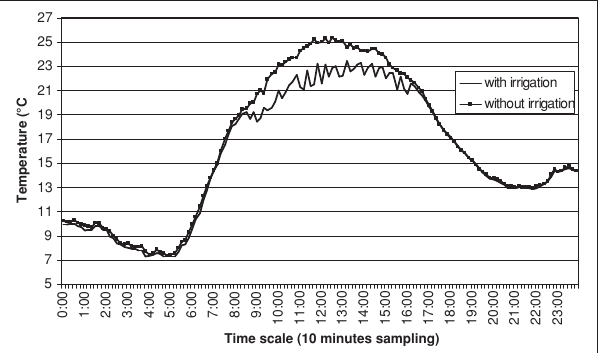
4,006,008,0010,0012,0014,0016,0018,0020,0022,0024,00 Figure 1 : Mean daily temperature in the apple plantation with and without irrigation between March 15 and April 15, 2010